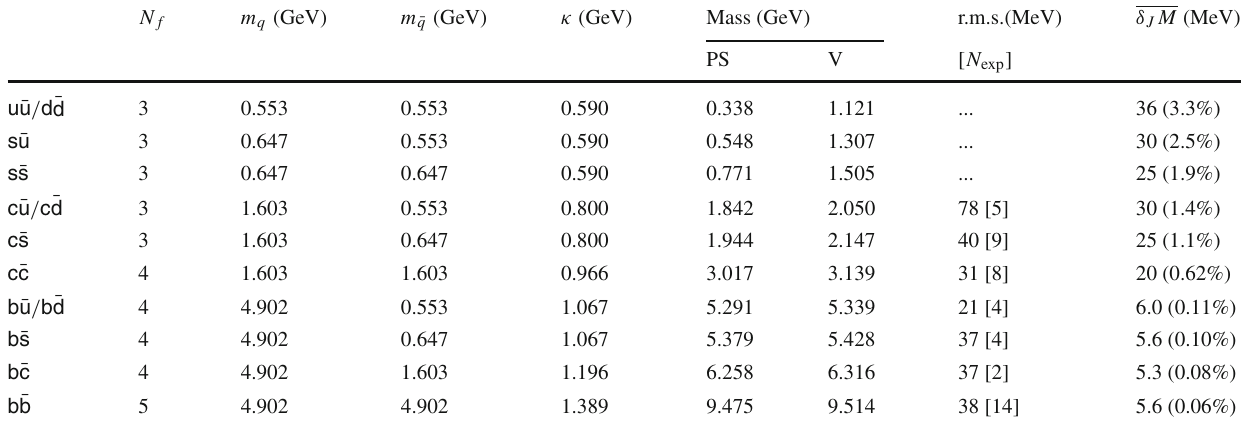
Table 1 Summary of the model parameters with the basis truncation N max = L max = 32. Among them m q ( m ¯ q ) = 0 . 553 GeV and 0 . 647 GeV are the two fitted parameters. The calculated meson masses of the two low-lying states, known as pseudoscalar (PS) and vector (V), are listed in the table. The r.m.s. are the root-mean-square differences of ourresultsfromtheexperimentalmeasuredmasses;thenumberofcom- pared states N exp are shown in the square brackets. The mean spread δ J M is the spread in the masses over allowed M J values and the devia-